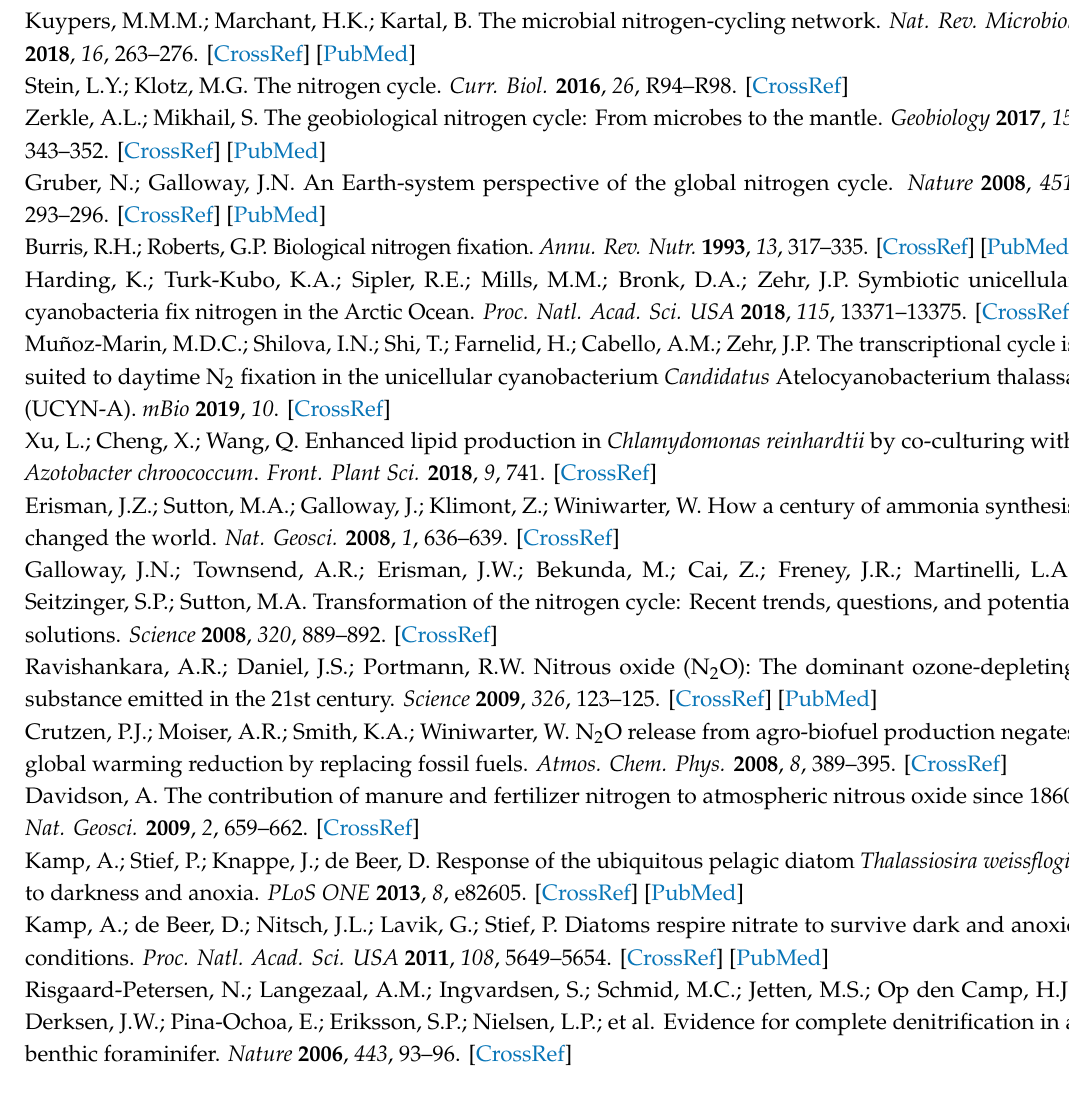
Figure S1. Evolutionary relationships of putative FLV proteins, Figure S2. Evolutionary relationships of putative HCP proteins, Figure S3. Evolutionary relationships of putative CYP55 proteins, Figure S4. Evolutionary relationships of putative NIRK